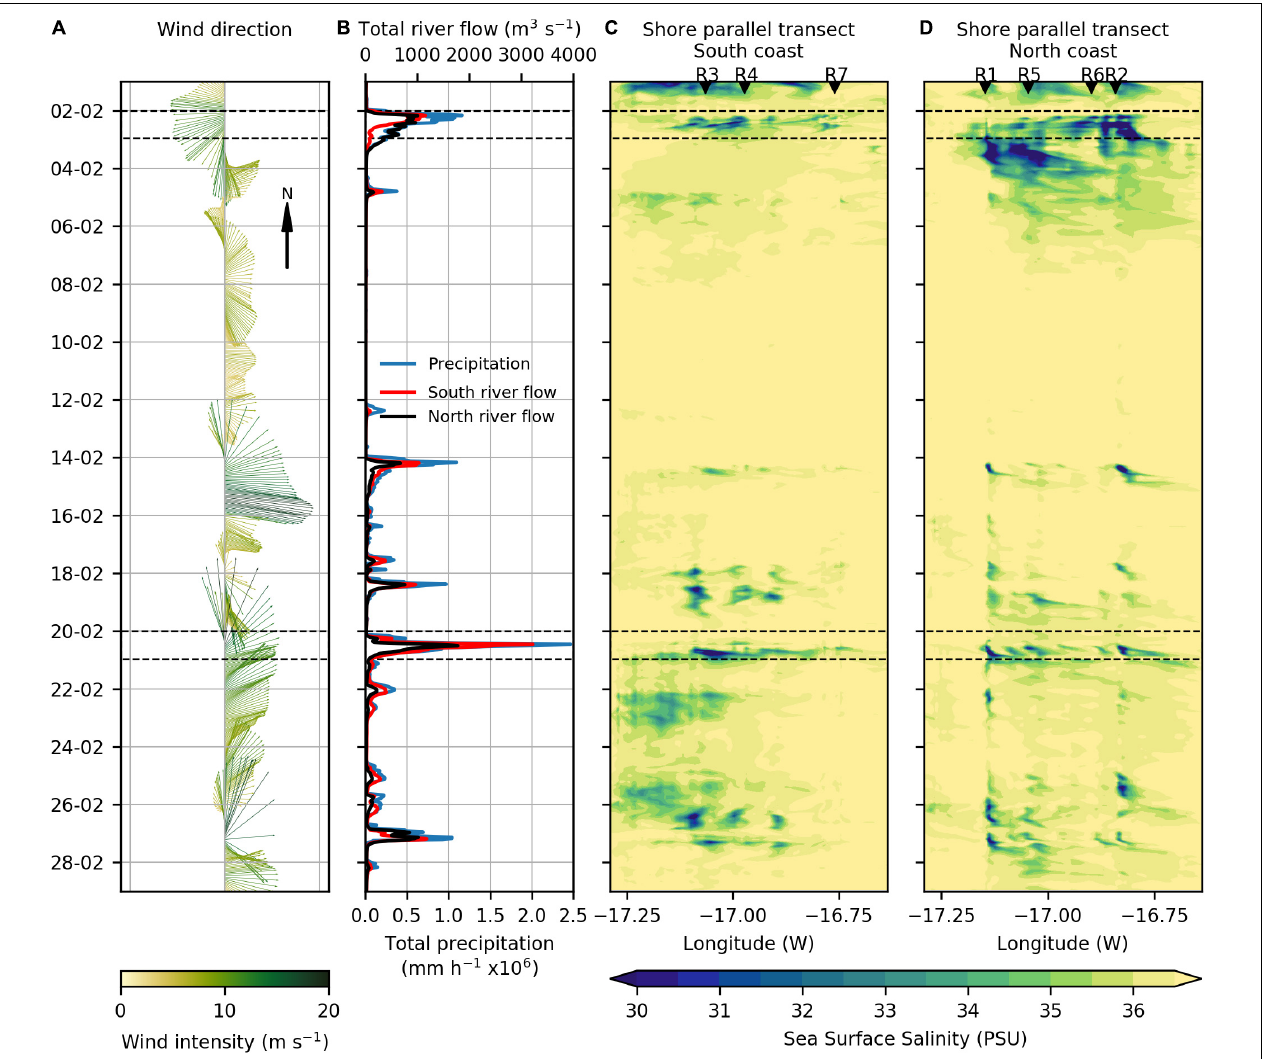
FIGURE 7 | (A) Spatial average of WRF model wind direction and intensity (m s − 1 ) for D3 domain, (B) total modeled river flow (m 3 s − 1 ) for rivers discharging in the south coast and north coast, along with the WRF model total precipitation (mm h − 1 ) calculated for the island (red, black and blue lines, respectively), Hovmöller diagrams for the modeled Sea Surface Salinity (PSU) obtained from the shore parallel transects along (C) the southern shoreline and (D) northern shoreline during February 2010. The shoreline transects are positioned around 2 km from the coast and labels R1–R7 indicate the position of the main river outlets (see Figure 3C for transects and river outlets location). Black dashed lines identify two flash flood